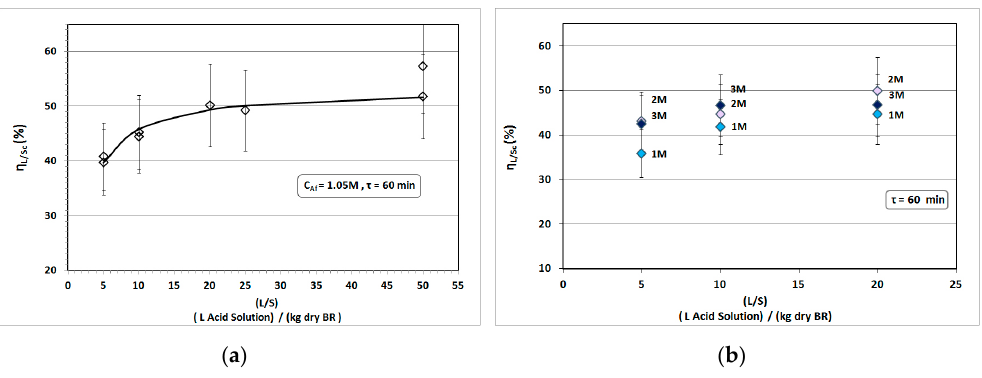
Figure 3. ( a ) Variation of Sc leaching yield ( η L/Sc ) with L/S ratio, for feed acid (sulfuric) concentration C Af = 1.05M, for constant mixing residence time τ = 60 min, mechanical stirring, ambient conditions, and C Sc/BR = 97 g/t (Solvent Excess data Series). Solid line is optimized fitting of Equation (3); ( b ) Variation of η L/Sc with L/S for 3 different feed acid (sulfuric) concentrations (1, 2 and 3M), under